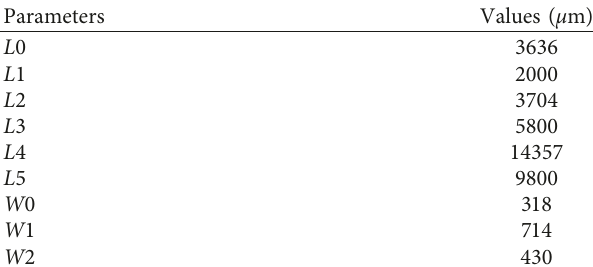
Table 4: Optimized parameters of the